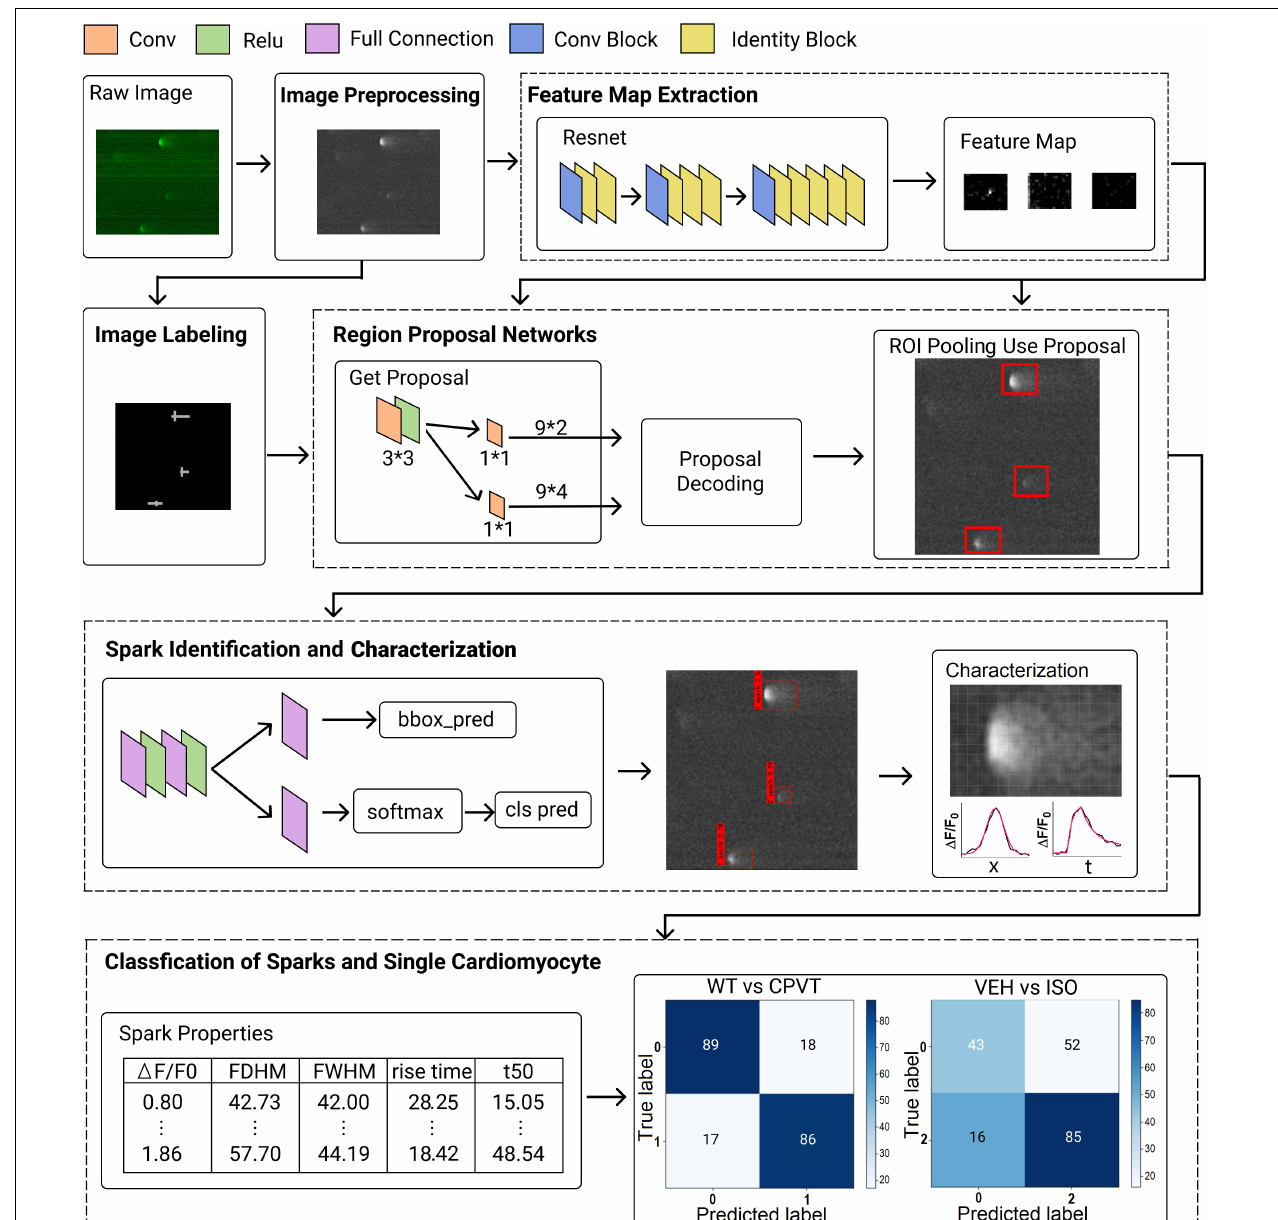
FIGURE 1 | Network architecture of proposed framework. The framework comprises several major processes, including image pre-processing and labeling, feature map extraction, region proposal network, spark identification and characterization, and classification of sparks and single